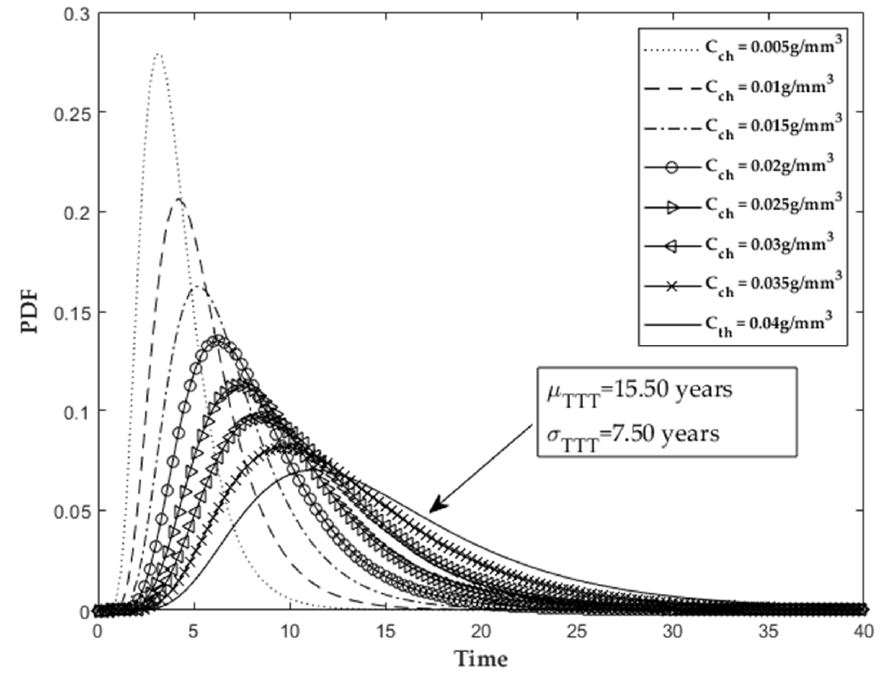
Figure 4. Probability distribution functions (PDFs) for corrosion initiation time and time to reach a certain C ch at the rebar level. Table 4. Expected time to reach specified chloride concentration at the rebar level and corresponding standard